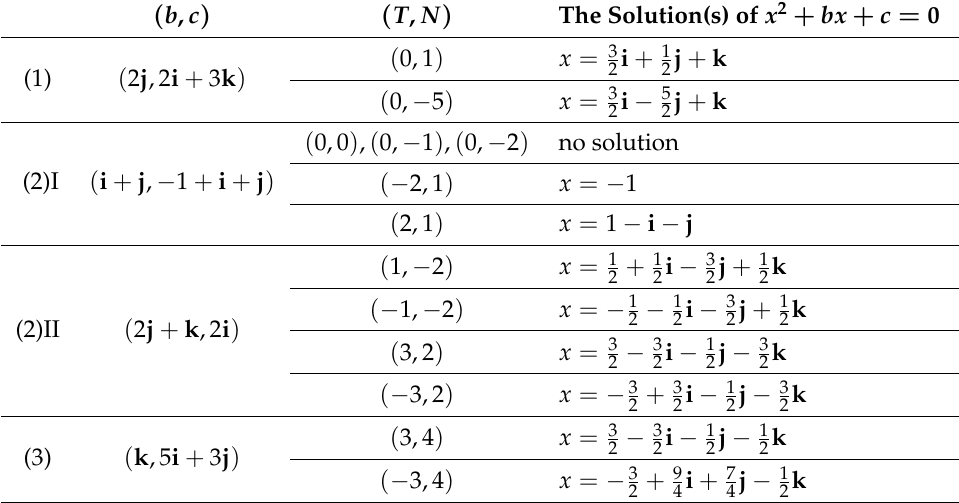
Table 2. Some examples in Theorem 2 with D = 0.